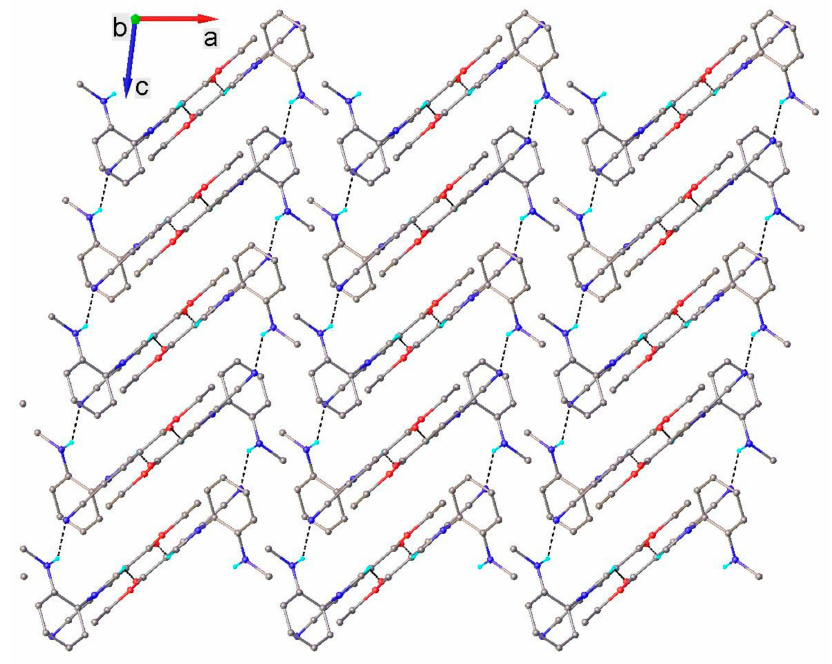
Figure 6. Crystal structure packing viewed along the b-axis. Non-relevant H-atoms are